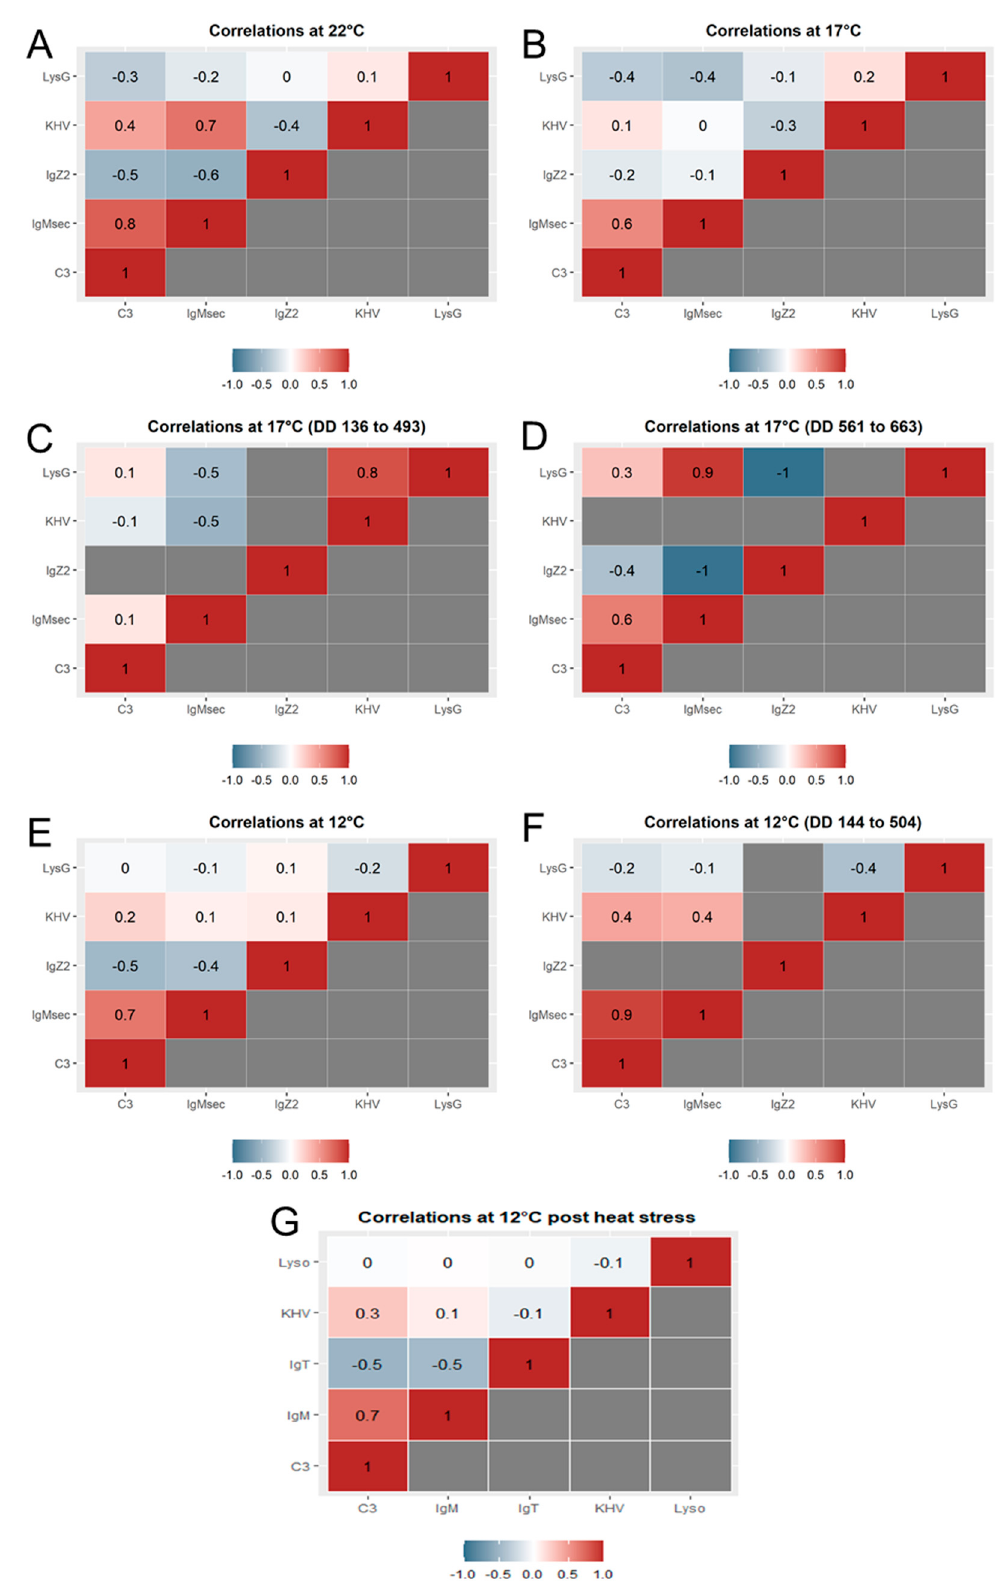
Figure 5. Pairwise correlation heat maps of the relative gene expression of complement c3-h1 ( c3 ), lysozyme g ( lysG ), immunoglobulin M heavy chain secretory protein ( IgMsec ), and immunoglobulin Z2 heavy chain ( IgZ2 ) in skin swabs taken from common carp exposed to koi herpesvirus (KHV) at either 22 °C ( A ), 17 °C ( B – D ), or 12 °C ( E – G ). Numbers indicate Pearson’s correlation coefficients. DD: degree day.